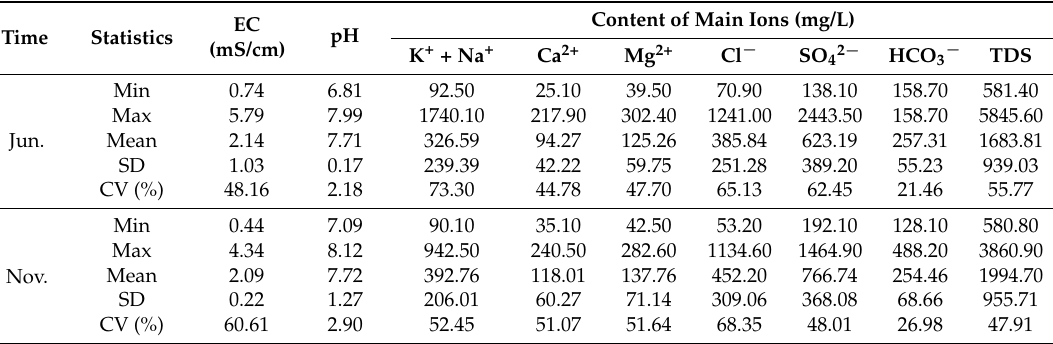
Table 1. Statistics of groundwater